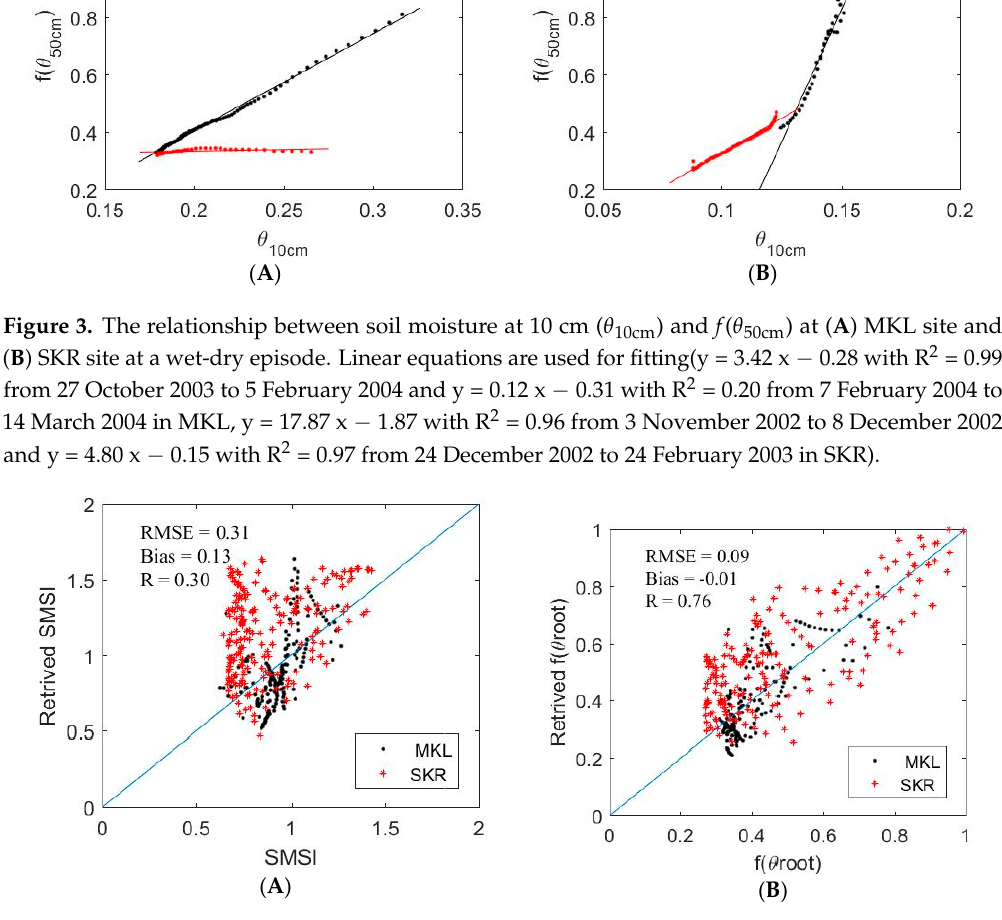
Figure 4. Scatterplot comparison of estimated ( A ) daily SMSI and ( B ) daily f ( θ root ) during dry season at MKL and SKR sites.